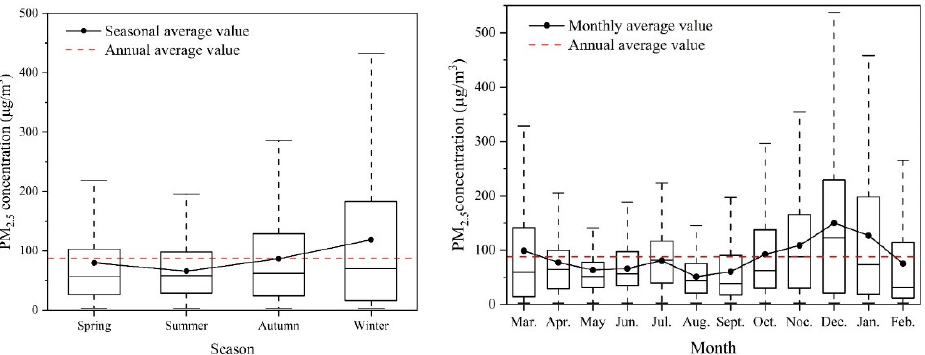
Figure 4. PM 2.5 concentration in Beijing from 3 December 2016–28 February 2017. Seasonal variation of PM 2.5 concentration (The picture on the left), Monthly variation of PM 2.5 concentration (The picture on the right).